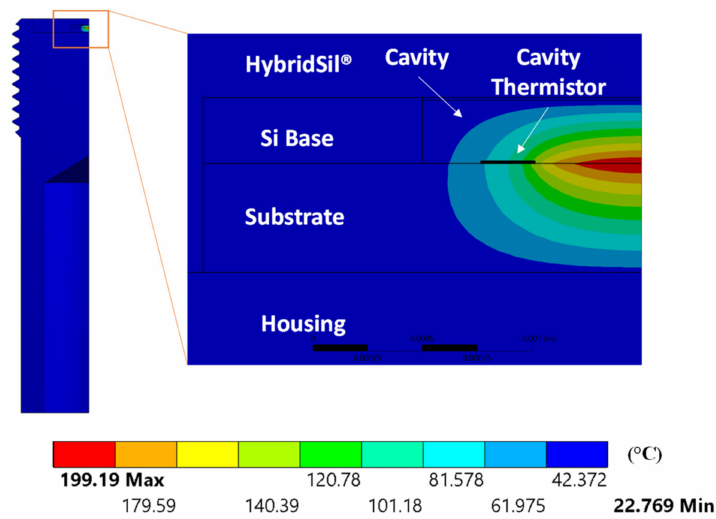
Figure 6. Temperature ( ◦ C) contour plot for the maximum heater voltage of 5 V. A large temperature gradient was observed in the reference cavity with a maximum temperature of 199.2 ◦ C at the bottom of the cavity where the heater was located and a minimum temperature of 29.4 ◦ C. The temperature gradient was physical, as no convection (forced or buoyancy-induced) occurred in the cavity, as discussed previously. However, this temperature gradient was significant as the current self-calibration procedure assumed a uniform cavity temperature as measured by the cavity thermistor located at the bottom of the cavity, resulting in potential self-calibration